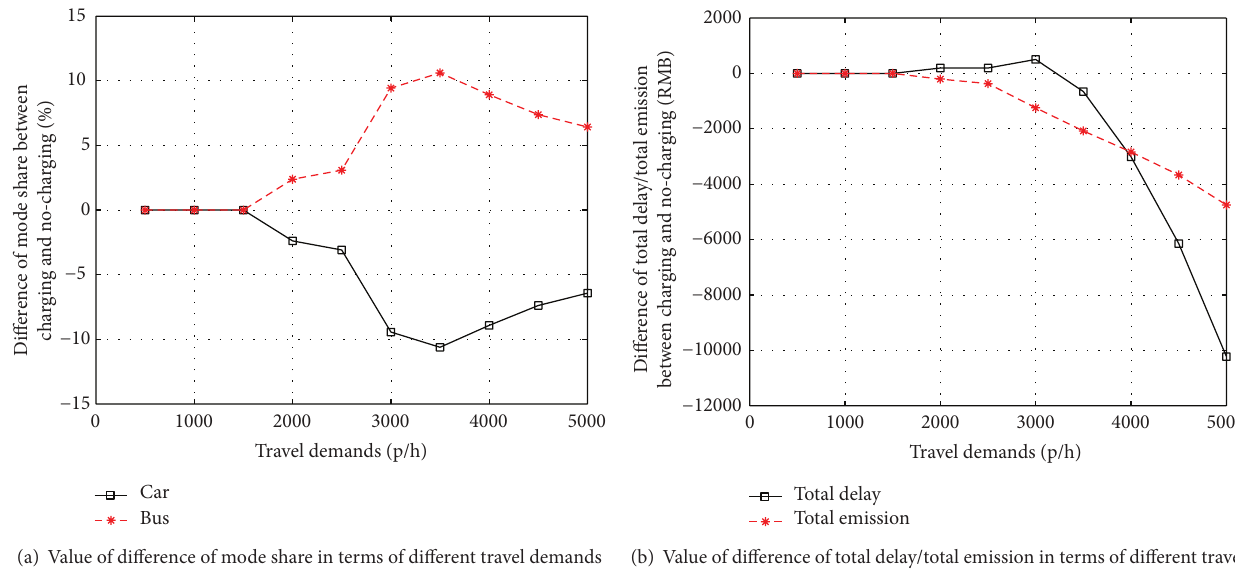
Figure 4: Comparative sensitivity analysis of travel demand between pricing and no-pricing.